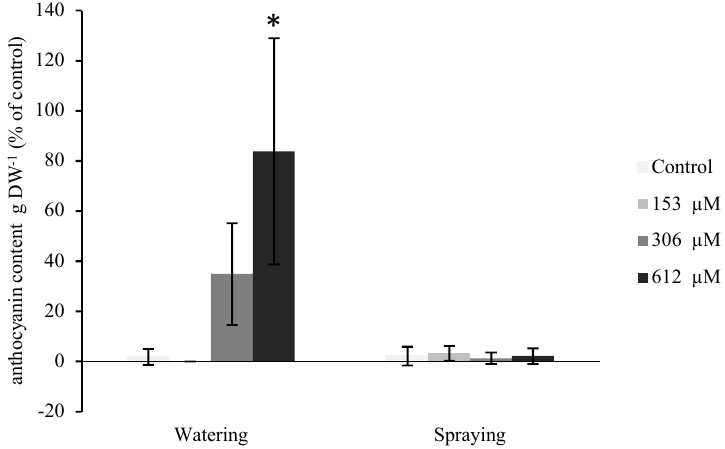
Figure 6. Anthocyanin content per gram of dry weight (DW) of A. thaliana plants watered and sprayed with different concentrations of norharmane (0, 153, 306 and 612 µM) for 21 days. Asterisks indicate significant differences compared to the control (* p ≤ 0.05). Data are given in percentage with respect to the control.